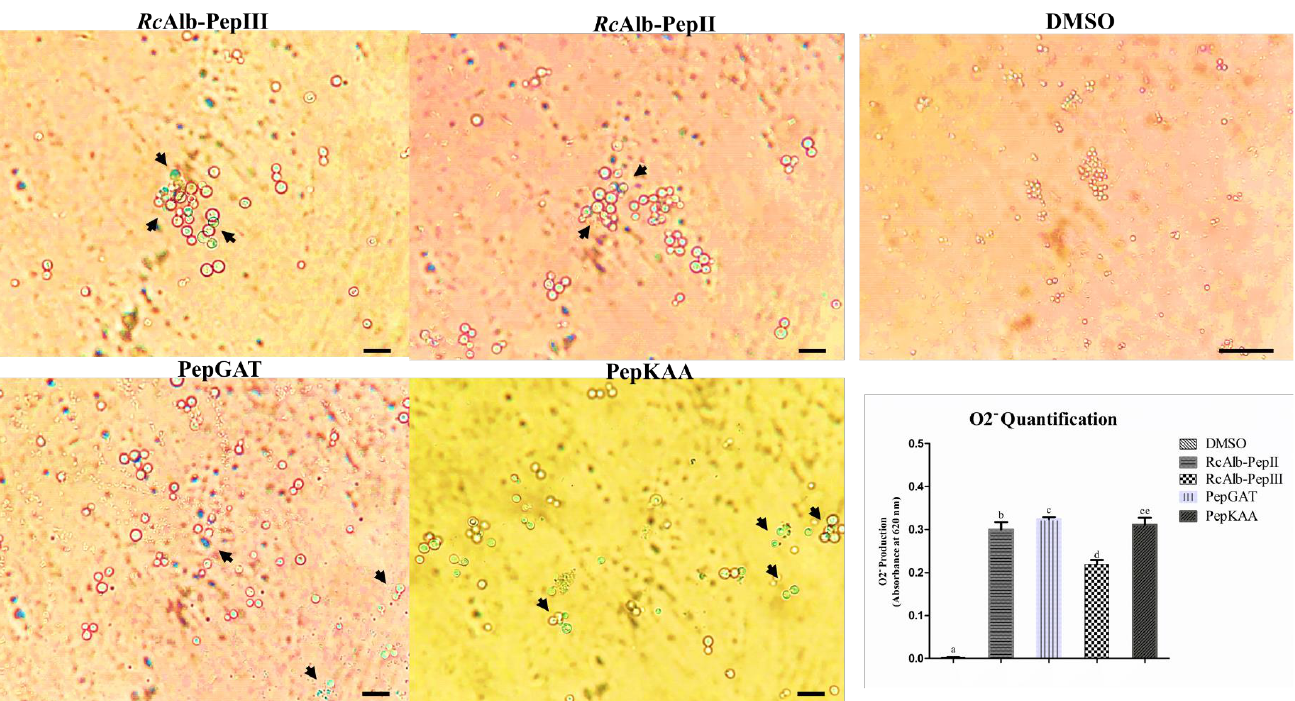
Figure 1. Qualitative and quantitative analysis of anion superoxide accumulation in C. neoformans . Light microscopy analysis of the conversion of NBT into formazan (blue or cyan dots–black arrows). The panel of DMSO represents the control cells, and other panels are treated C. neoformans cells with synthetic peptides. The inserted graphic represents the quantitative analysis of anion superoxide accumulation in C. neoformans cells. In control bar indicates 100 µ m. In treated cells bar indicate 50 µ m. The different lowercase letters indicate statistical significance at p > 0.05.